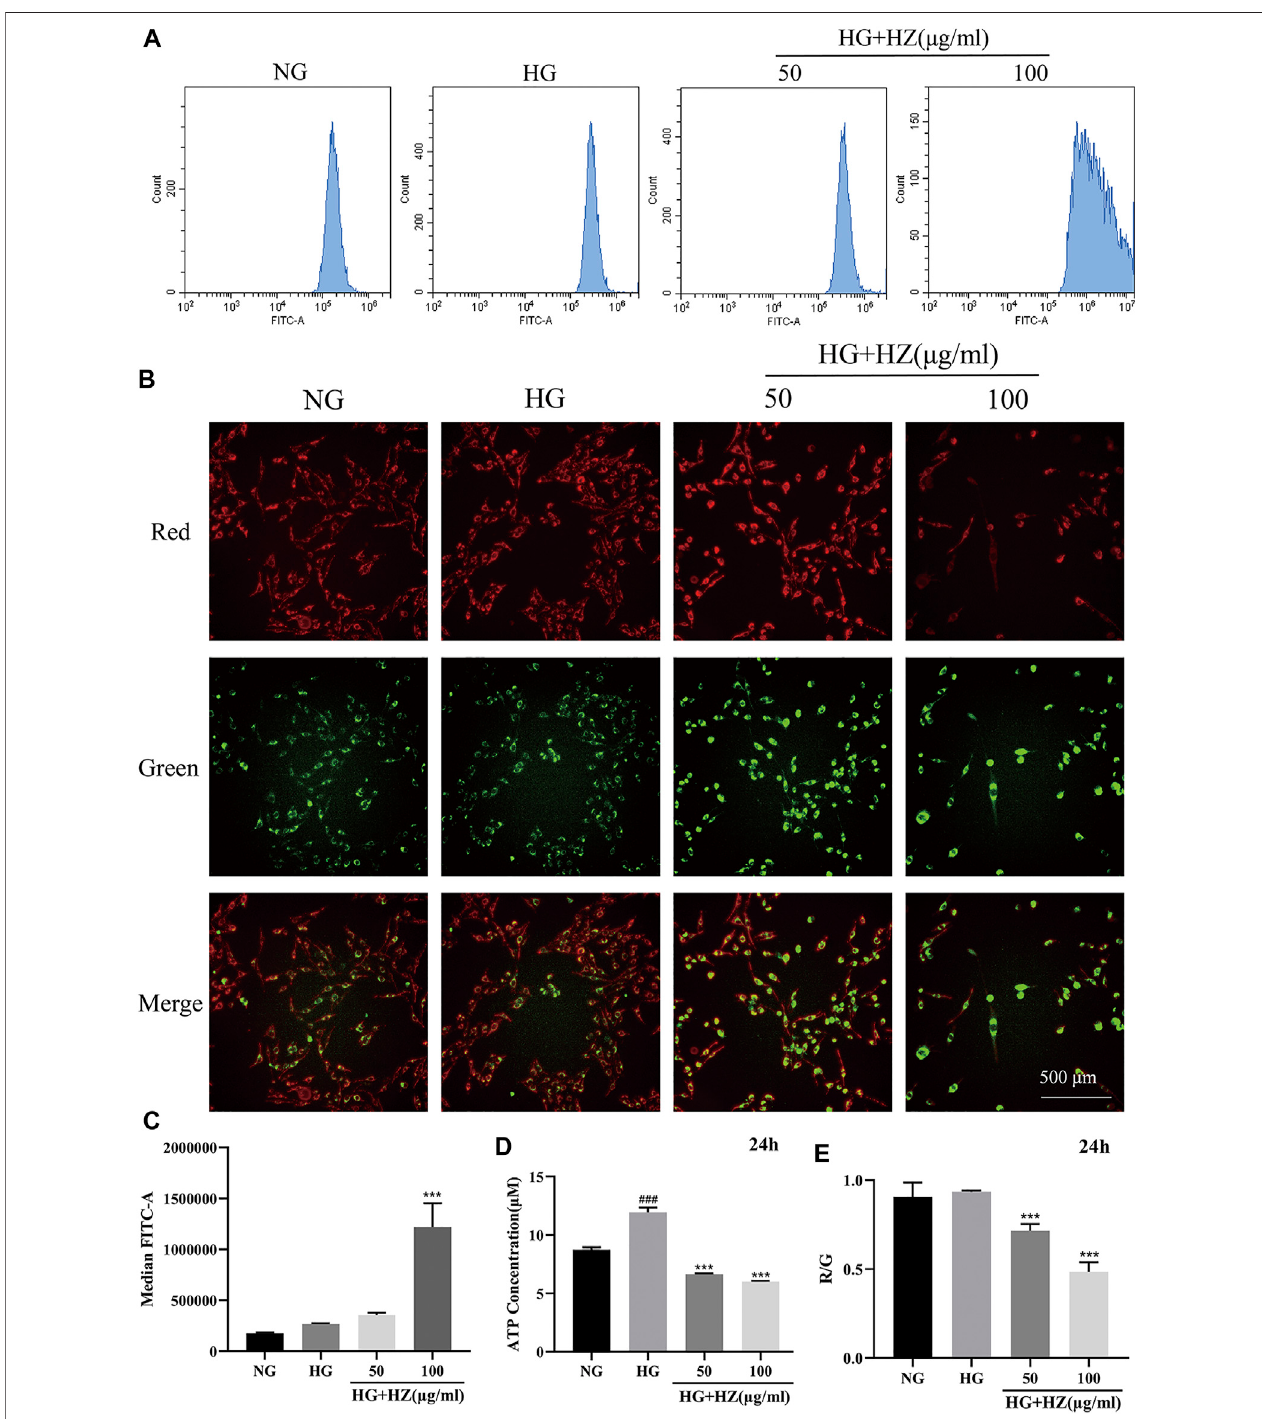
FIGURE 5 | HZQMY regulated ROS and ATP levels, and promoted MMP collapse. (A) Cellular ROS level was detected by fl ow cytometry. (B) The red and green fl uorescence of the cells was measured by high content cell imager. (C) The ROS level was analyzed. (D) Cellular ATP level was detected by ATP assay kit. (E) R/G represents the change of MMP. ### indicates p < 0.001 compared with NG group. *** indicates p < 0.001 compared with HG group. HZ: HZQMY.